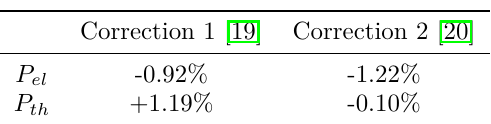
Table 2. Variation obtained in [19] per each 1 °C from 17 °C; variation obtained in [20] per each 1 °C from 15